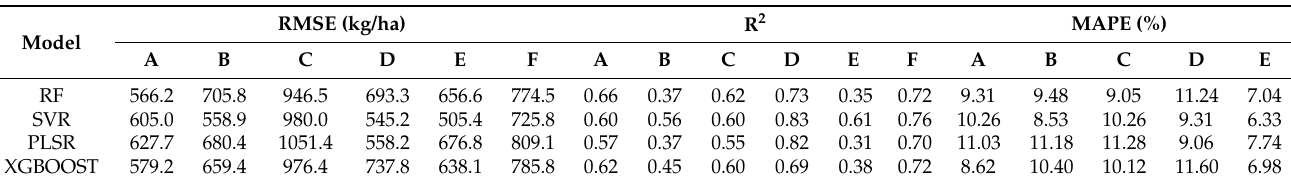
Table 3. Accuracy evaluations comparison among different